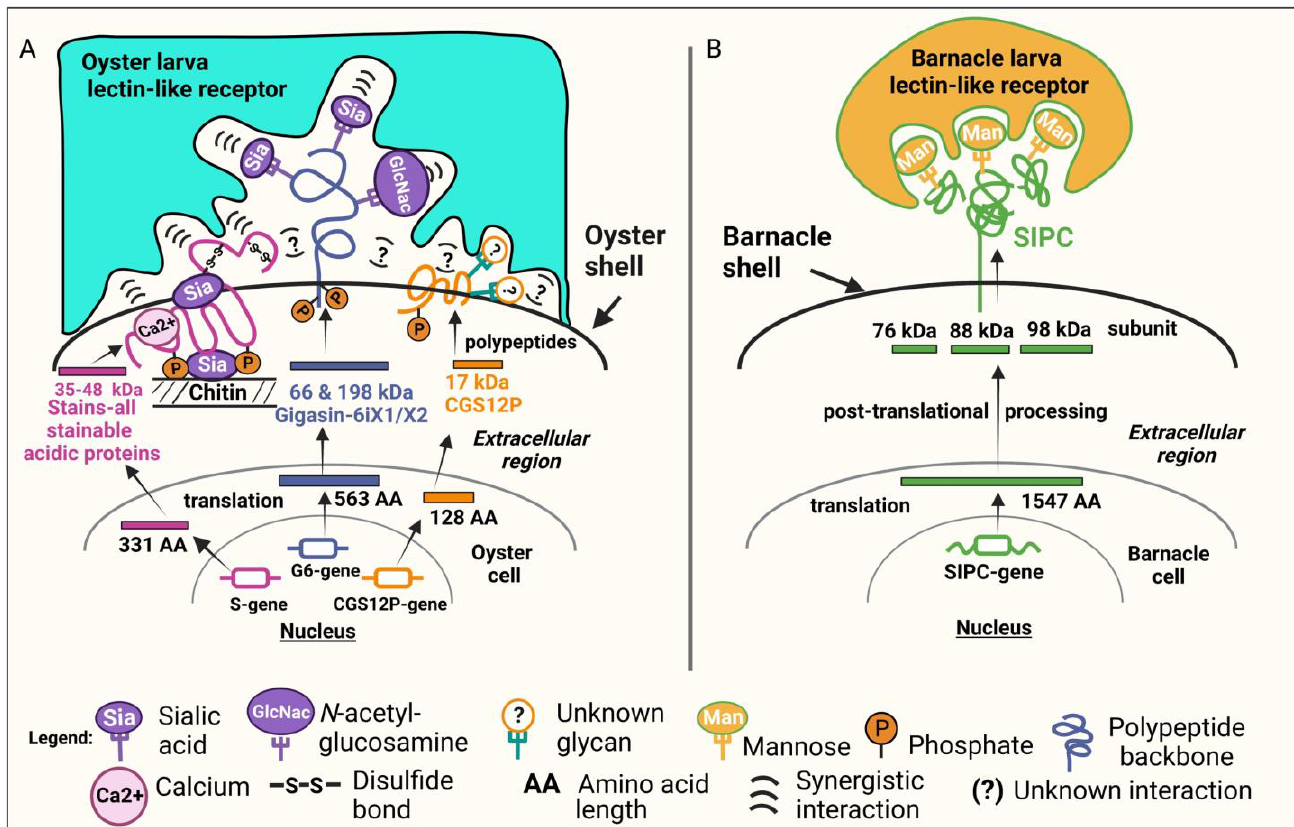
Figure 6. Comparison of settlement-inducing cues in oysters and barnacles. ( A ) Supramolecular interaction of several unrelated genes from adult oyster shells as Crassostrea gigas Settlement Pheromone Protein Components (CGSPPC). ( B ) Settlement-Inducing Protein Complex (SIPC) is encoded in a single gene in the barnacle, Balanus amphitrite . For comparison purposes, the authors illustrated the concept model in Figure 6B based on the reports by Dreanno et al. [45] and Matsumura et al. [46]. This figure was created using BioRender.com (accessed on 25 July